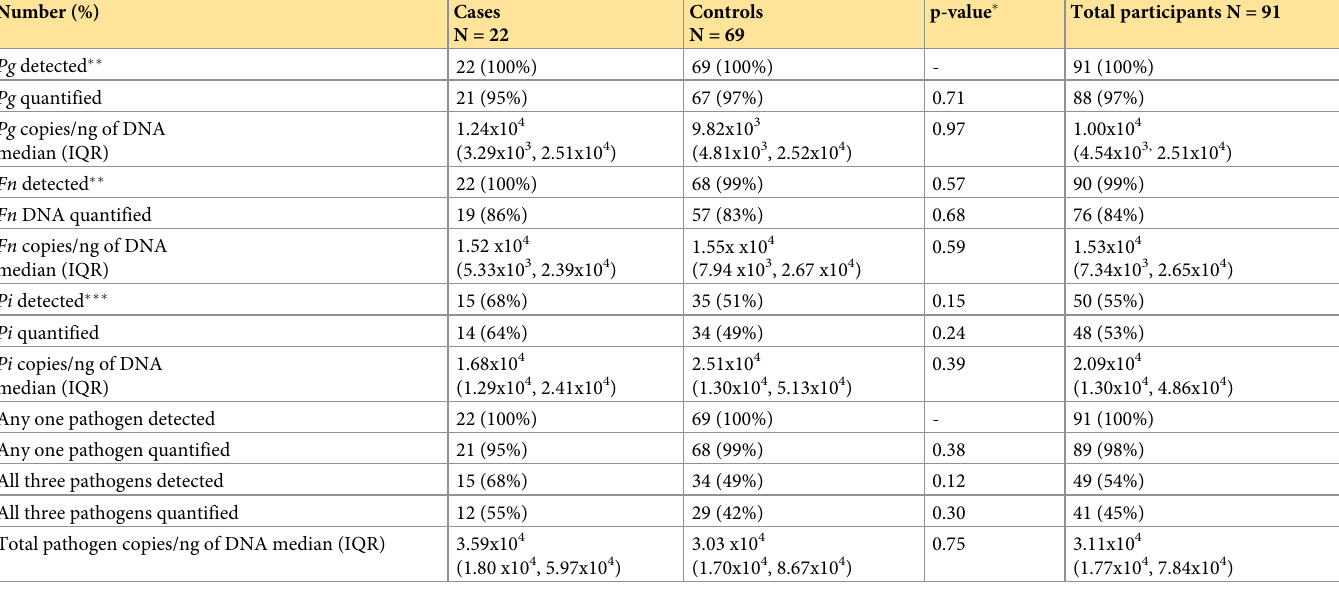
Table 2. Distribution of P . gingivalis (Pg) , F . nucleatum (Fn) and P . intermedia (Pi) in salivary rinse samples of participants with and without a clinical diagnosis of oral leukoplakia between 2014 and 2016 (N = 91).